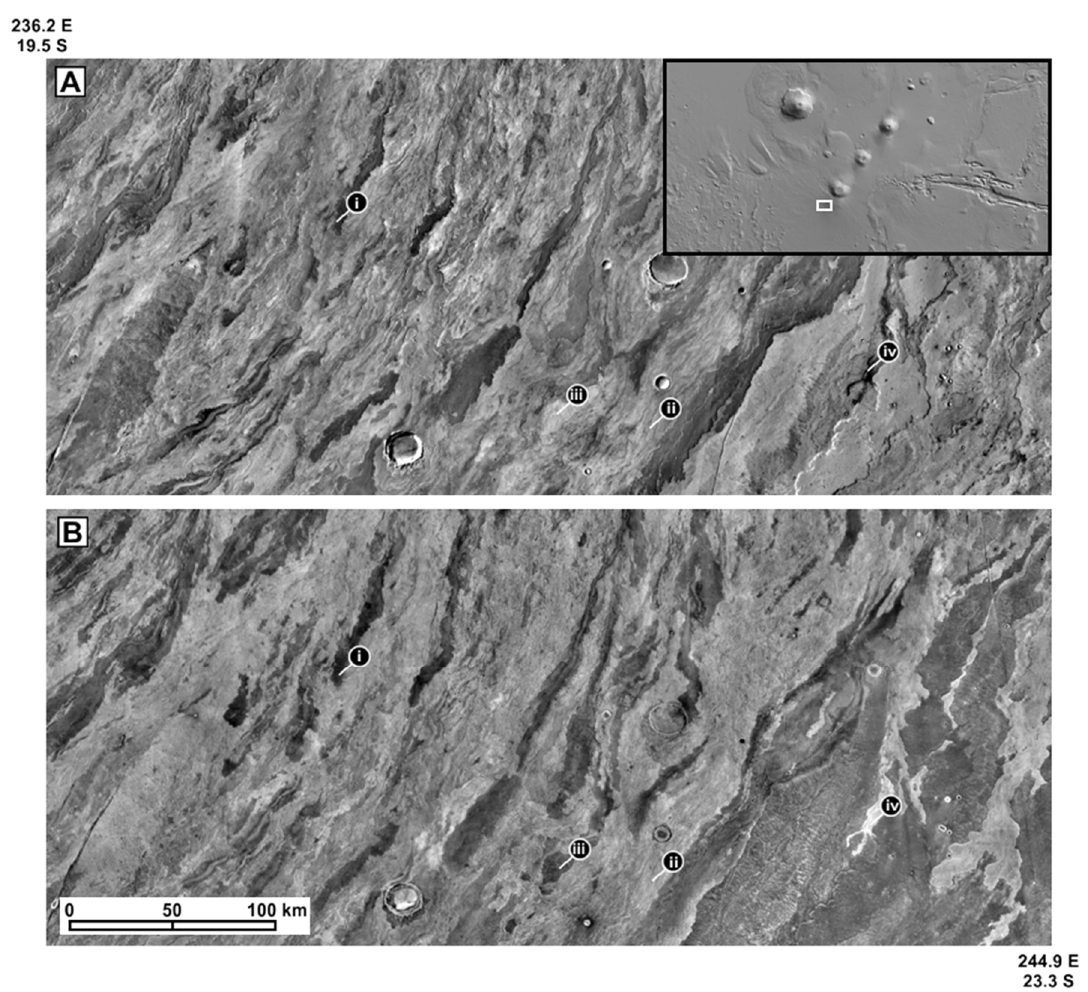
Figure 1. THEMIS IR global composite (100 pixel/degree) of a portion of the southern Arsia Mons flow field. ( A ) Day; ( B ) Night. Locator pins identify common examples of the four different thermophysical behaviors exhibited by individual lava flows over the diurnal cycle: (i) unchanging temperature, always cool; (ii) unchanging temperature, always warm; (iii) changing temperature; warm during the day and cool at night, indicative of a low thermal inertia surface; (iv) changing temperature, cool during the day and warm at night, indicative of a high thermal inertia surface. Inset is a MOLA-derived shaded relief image with the study area denoted by the white box.